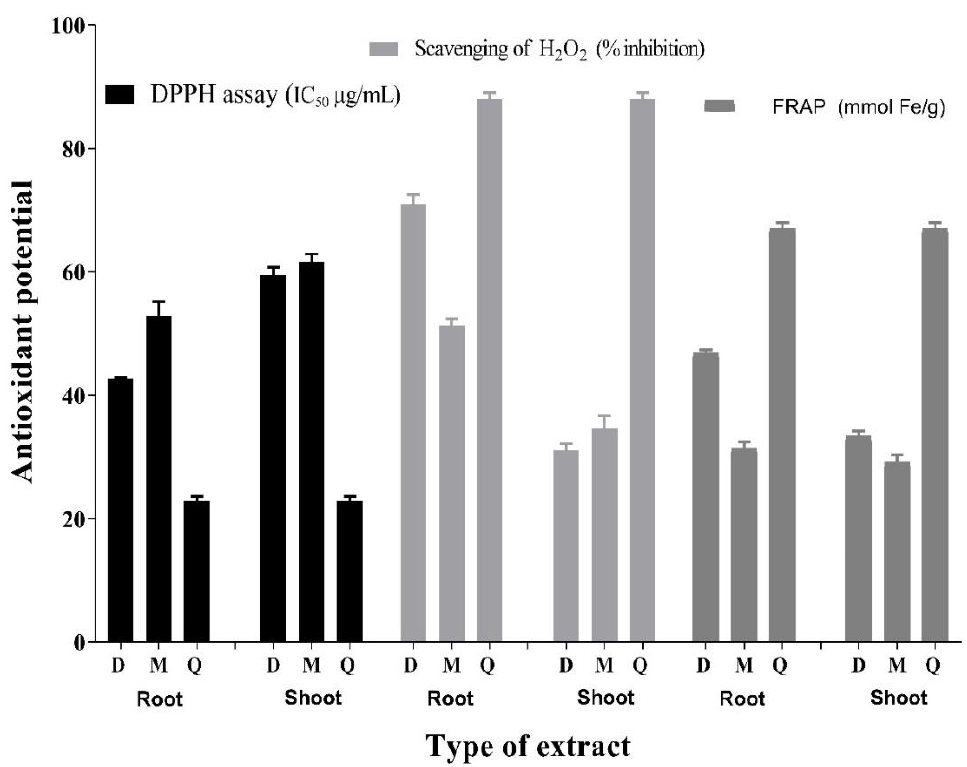
Figure 2. Antioxidant activity of Dryopteris juxtapostia root and shoot crude extracts. D, 100% dichloromethane extract; M, 100% methanol extract; Q, quercetin (standard). Values are presented as means ± S.D. of three measurements.